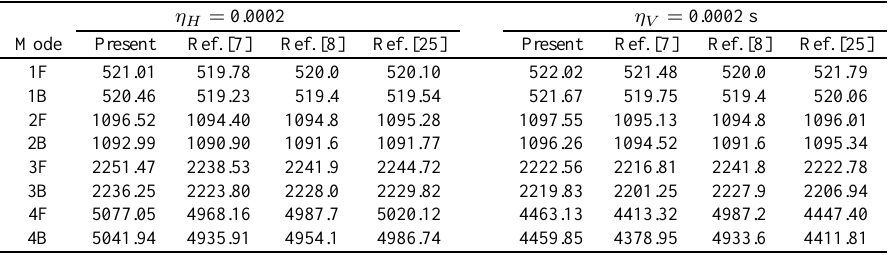
Table 1 Whirl speeds in rad/s ofa uniform shaft with isotropic undamped flexible bearings at aspin speed of4000 rpm